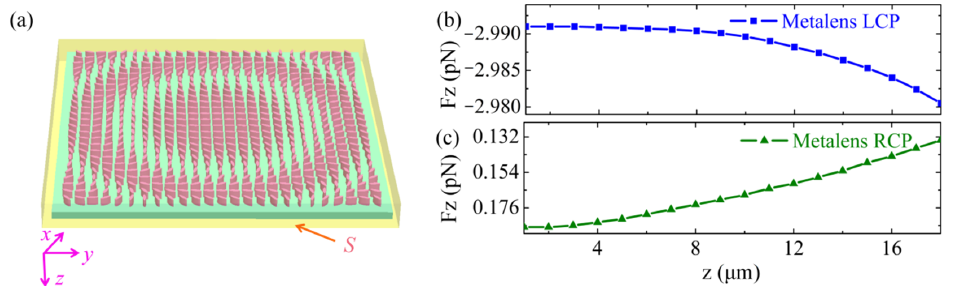
Figure 4. The longitudinal optical force for metalens. ( a ) Schematic of a metalens enclosed by the highlighted surface S. The longitudinal optical force profiles of a metalens illuminated by the divergent ( b ) LCP and ( c ) RCP Gaussian beam in a vacuum, respectively. The curves are interpolated from the calculated data points.